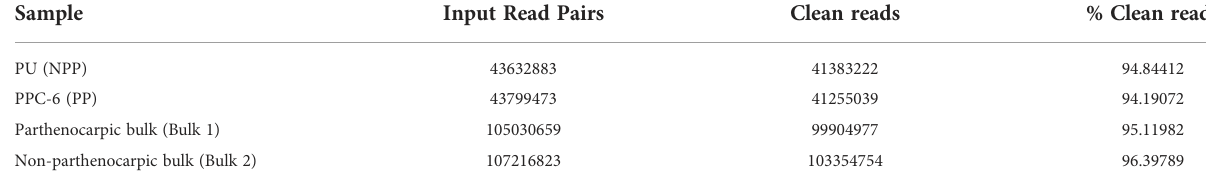
TABLE 2 Summary of reads ’ statistics of the re-sequenced samples of the parents along with the contrasting bulks.